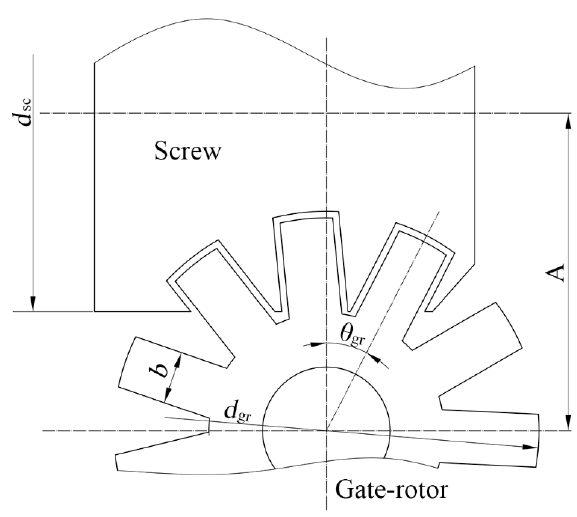
Figure 3. The basic geometric parameters of a meshing pair. Table 1. Main parameters of the